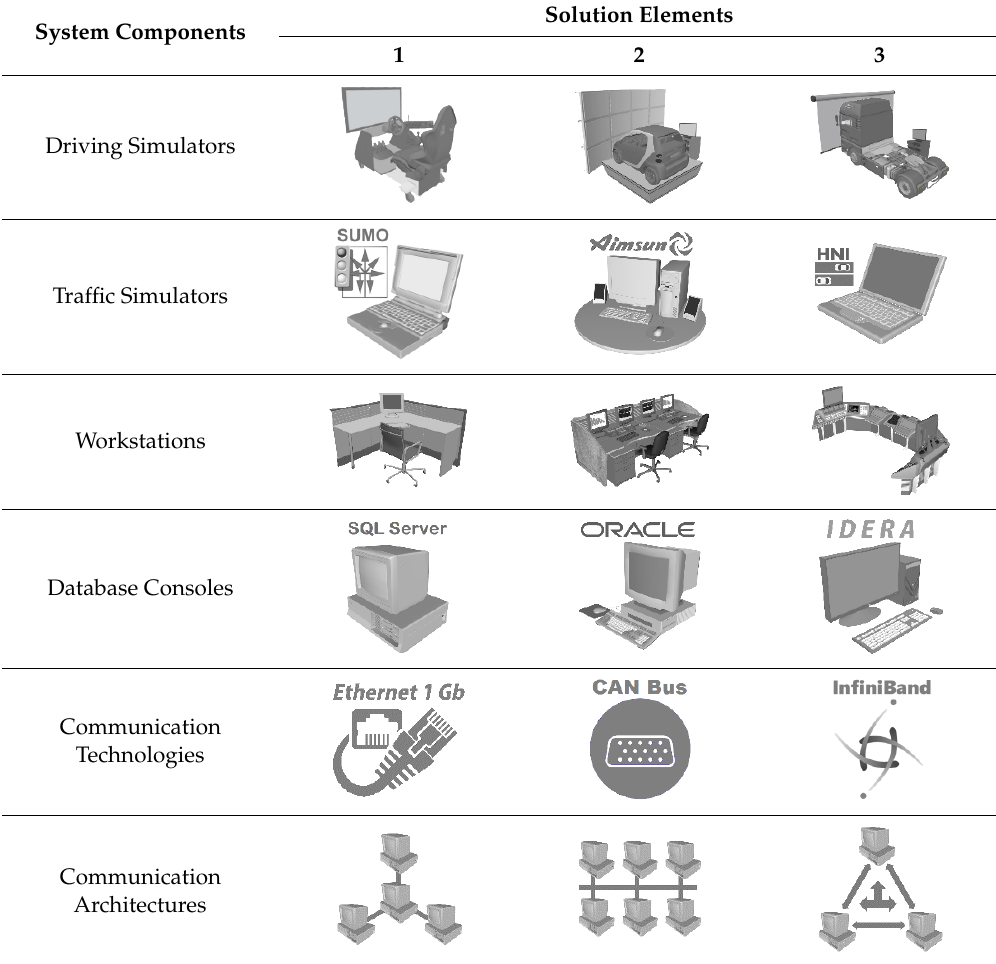
Table 11. Morphological box of the networked driving simulation system (excerpt).